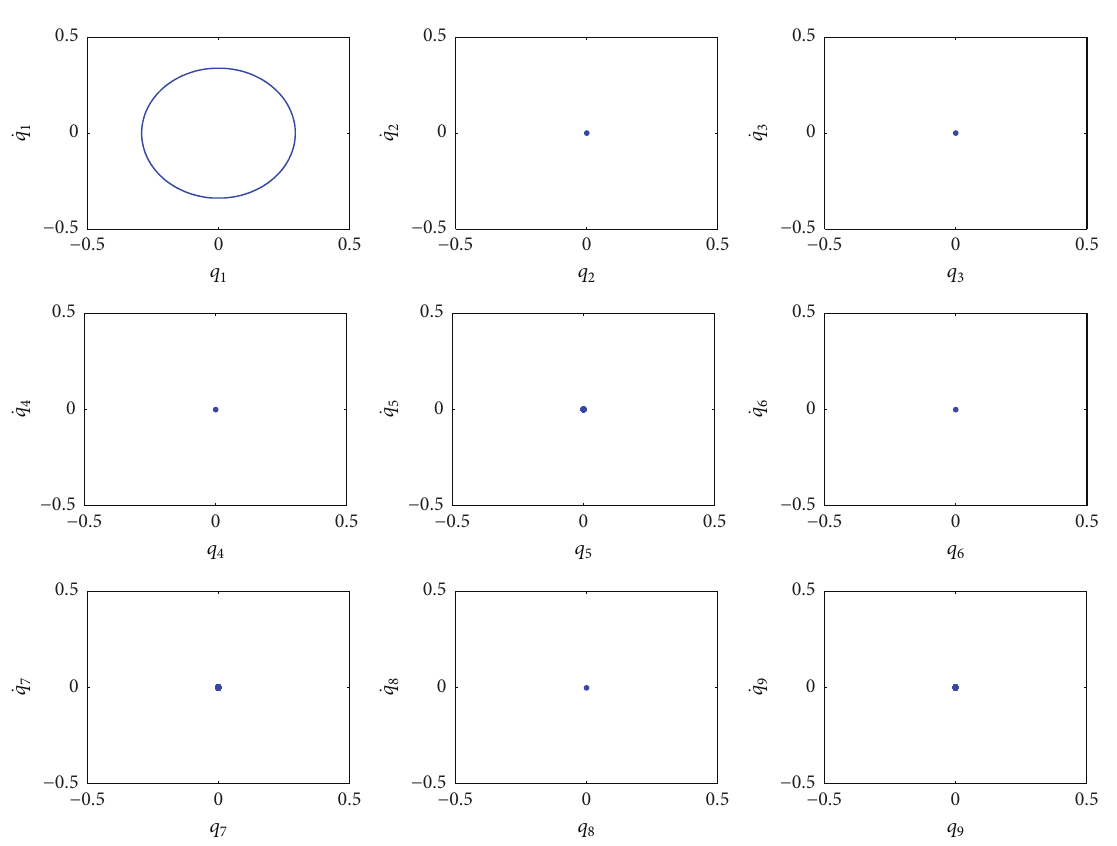
Figure 7: Two different stable limit cycles corresponding to different initial configurations.